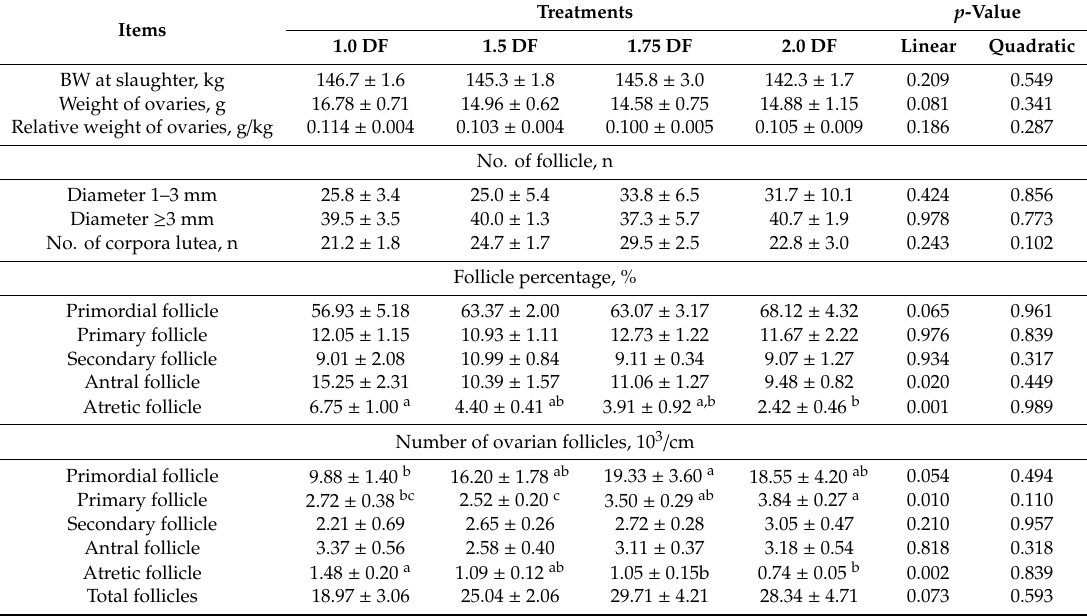
Table 6. E ff ects of dietary fiber levels on development of follicles in gilts on the 19th day of the 3rd estrous